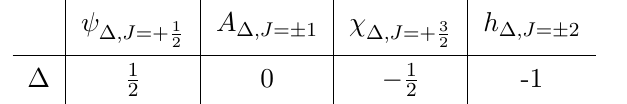
Table 3. Soft theorems without conformal Goldstones for 1